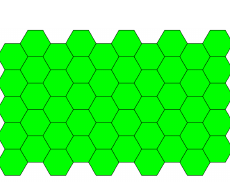
Figure 1. Hexagonal tiling